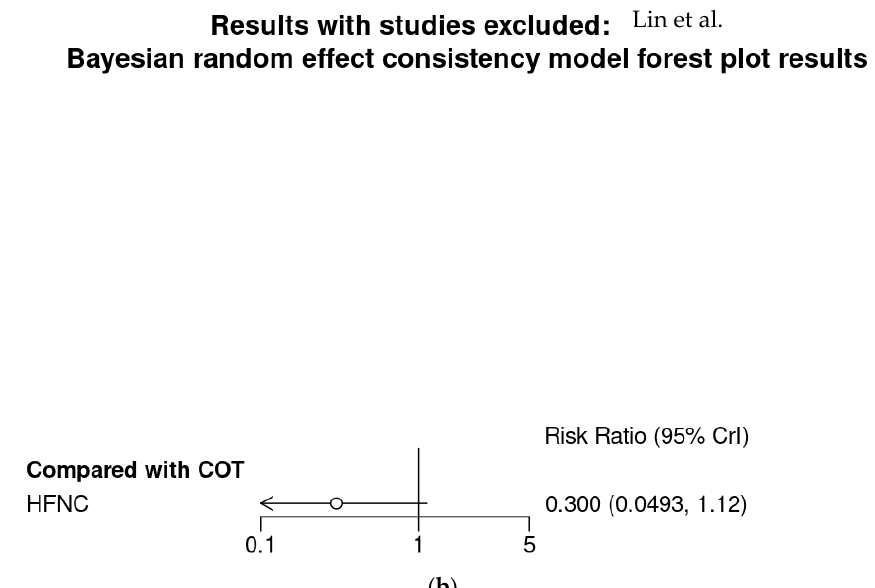
Figure A5. Bayesian random effect consistency model Outcome: Severe hypoxemia. ( a ) All four studies. ( b ) Three studies with patients at moderate to high risk for hypoxemia.